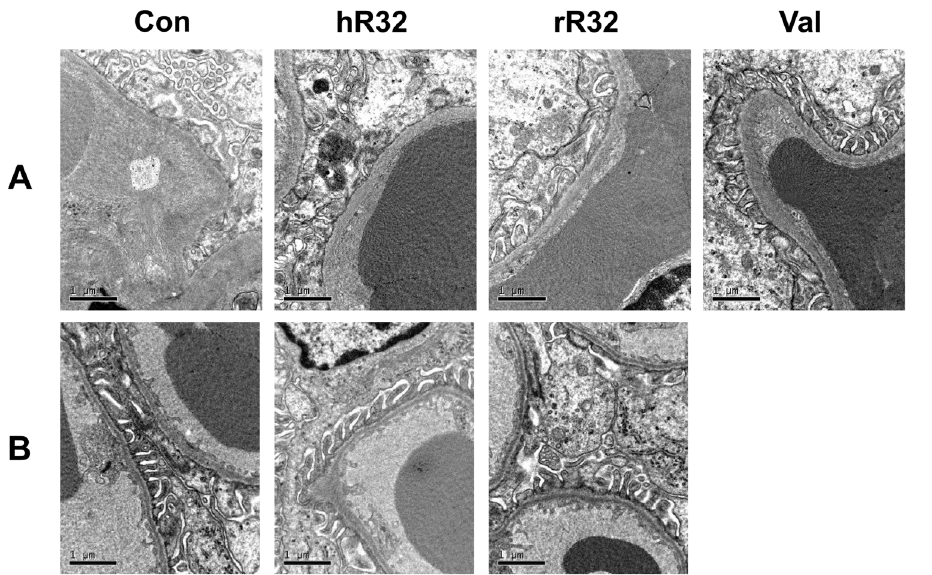
Figure 7. No immnue-complex was observed in the vaccinated animals under TEM. The representative kidney images showed that the basement membrane of glomeruli retained its integrity, and no characteristic immune-complex was observed in SHRs ( A) and WKYs ( B ). Meanwhile, cells proliferation of the mesangial region was observed in the control group, but not in the vaccine goups and valsartan group ( A) .